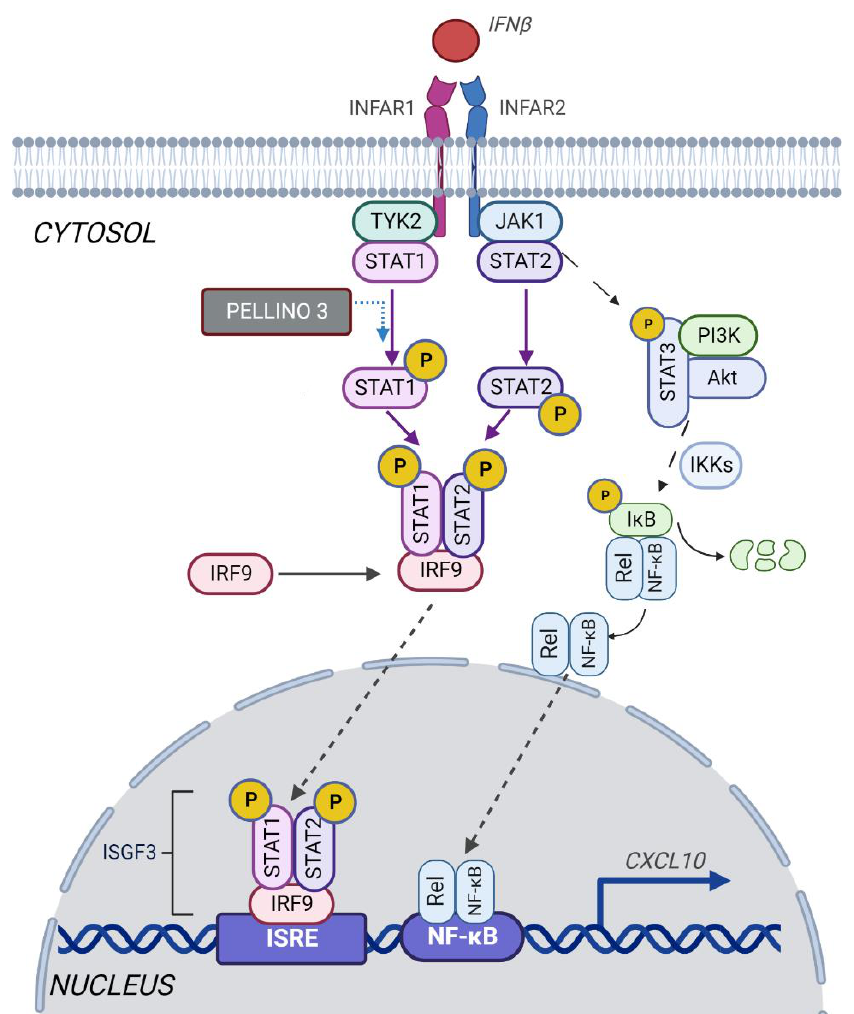
Figure 7. Pellino3 regulates IFNβ -induced STAT1/STAT2/IRF9- dependent activation of CXCL10 . Figure created with biorender.com (accessed on 20 September – 20 October 2022).